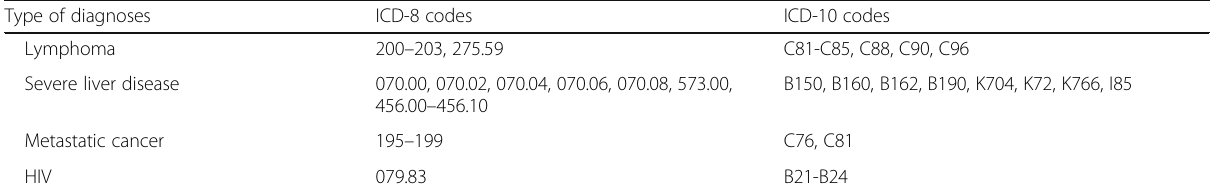
Table 1 Diagnostic codes for dementia and included covariates from the International Classification of Diseases (Continued) Type of